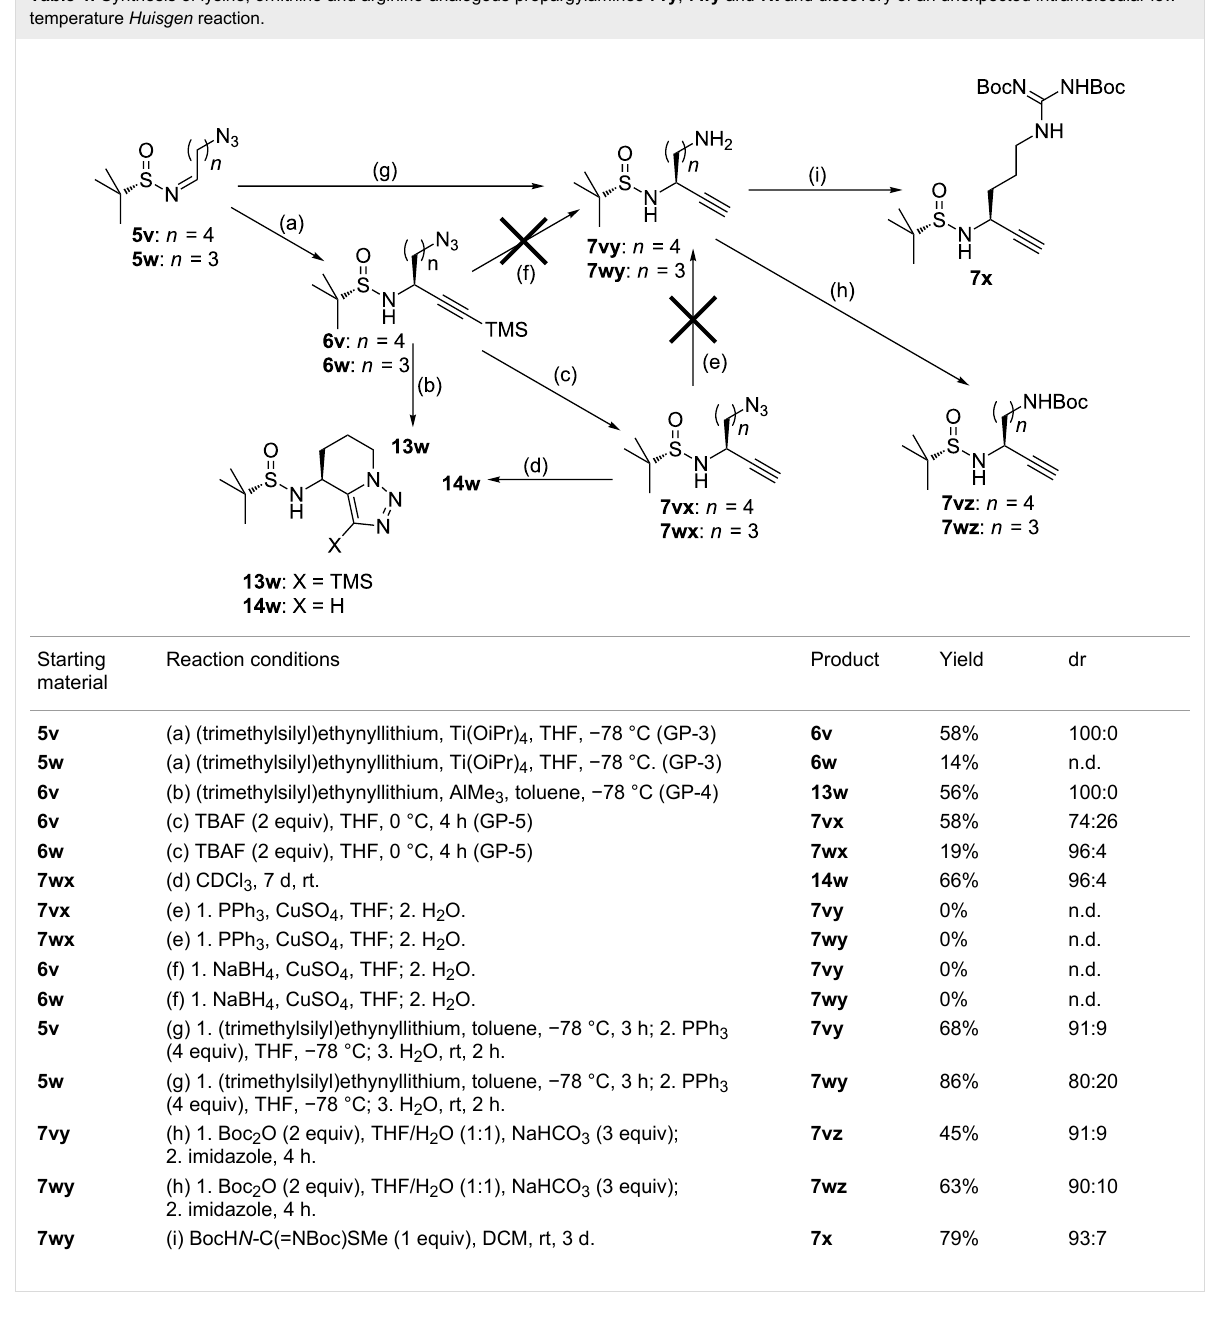
Table 4: Synthesis of lysine, ornithine and arginine-analogous propargylamines 7vy , 7wy and 7x and discovery of an unexpected intramolecular low- temperature Huisgen reaction.